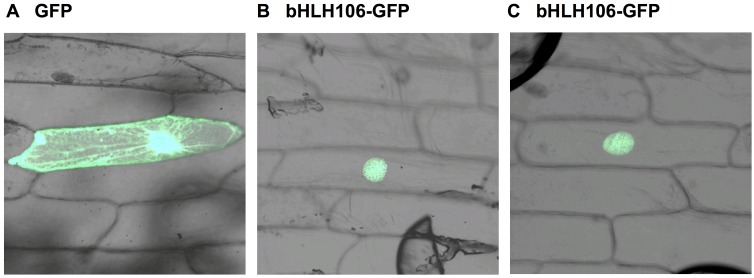
Intracellular localization of bHLH106.The construct of bHLH106 fused with GFP was bombarded into onion epidermal cells. Transient expression of GFP was observed. (A) Bombarded with GFP alone construct, pTH2 [49, 64]. (B, and C) Bombarded with bHLH106 fused with GFP.